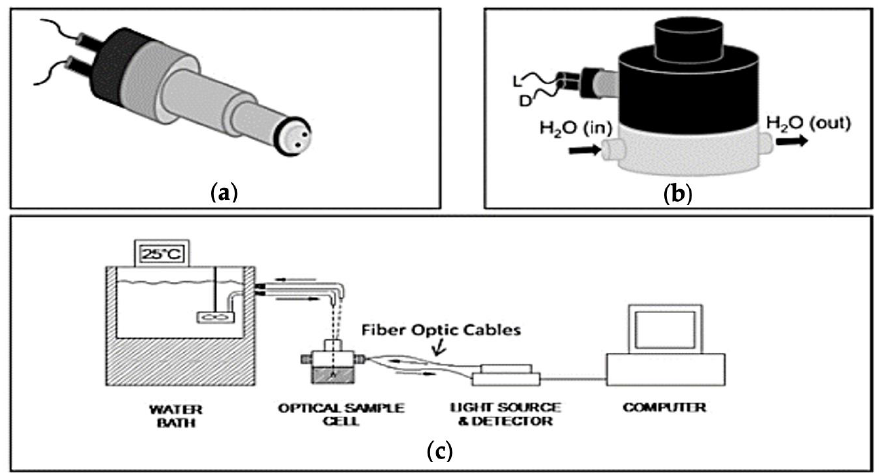
Figure 4. ( a ) The light backscatter probe; ( b ) the optical sample cell: L is the light source, D is the detector; ( c ) the complete optical system. Reprinted/adapted with permission from Ref. [7]. Lamb et al. [7] studied the relationship between changes in the size of casein micelles and the denaturation of milk whey proteins. This technique relies on variations of backscatter light intensity according to wavelength and particle diameter. After heat denaturation, β -lactoglobulin aggregates and binds to casein micelles, whose diameter increases. Although a priori, the wavelength intervals used varied from 200 – 1100 nm; the highest response was observed at wavelengths ranging 500 – 900 nm. This optical method proposed by [7] showed a proper correlation with data collected with cur- rently used techniques (SDS-PAGE and differential scanning calorimetry). Nevertheless, the optical method tended to slightly overestimate the amount of protein denaturation. Furthermore, protein aggregates produced during denaturation may also affect this technique [5].